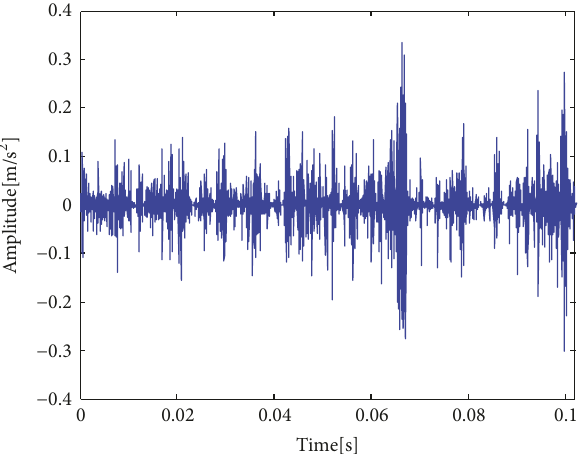
Figure 11: Time waveform of vibration signal. Figure 12: Time waveform of denoised vibration signal.